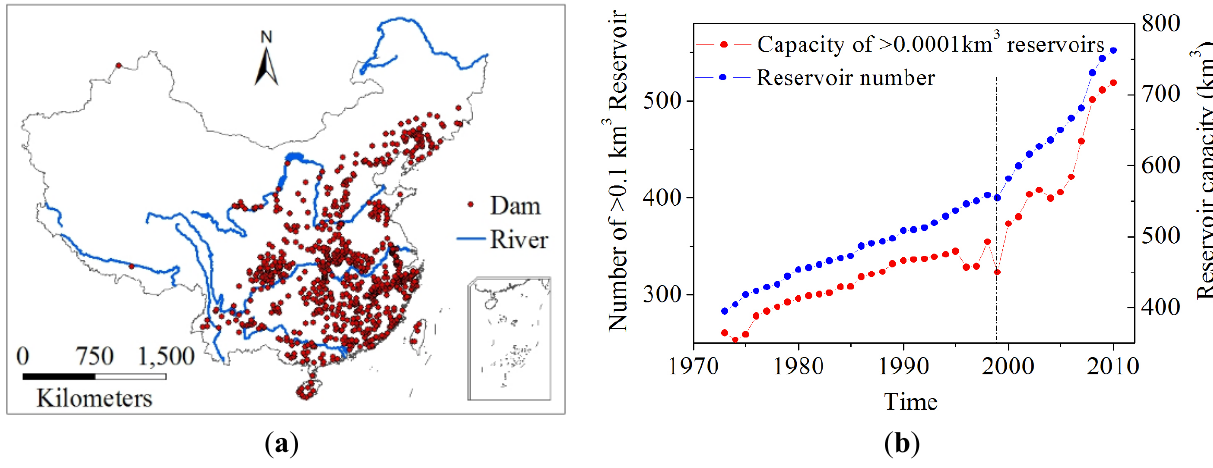
Figure 1. Distribution of dams throughout China in 2011 ( a ); and growth in the number of large reservoirs and the total capacity of reservoirs in China over the past 30 years ( b